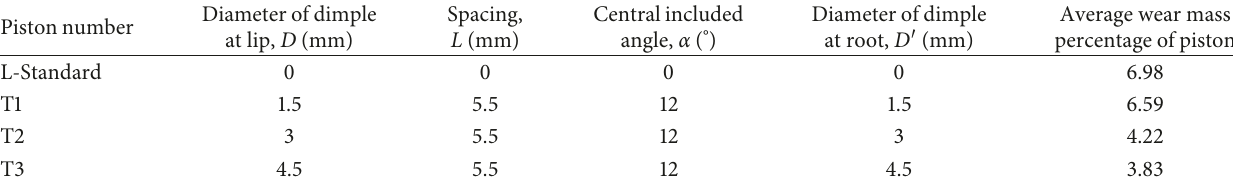
Table 3: Wear patterns of pistons with different dimple